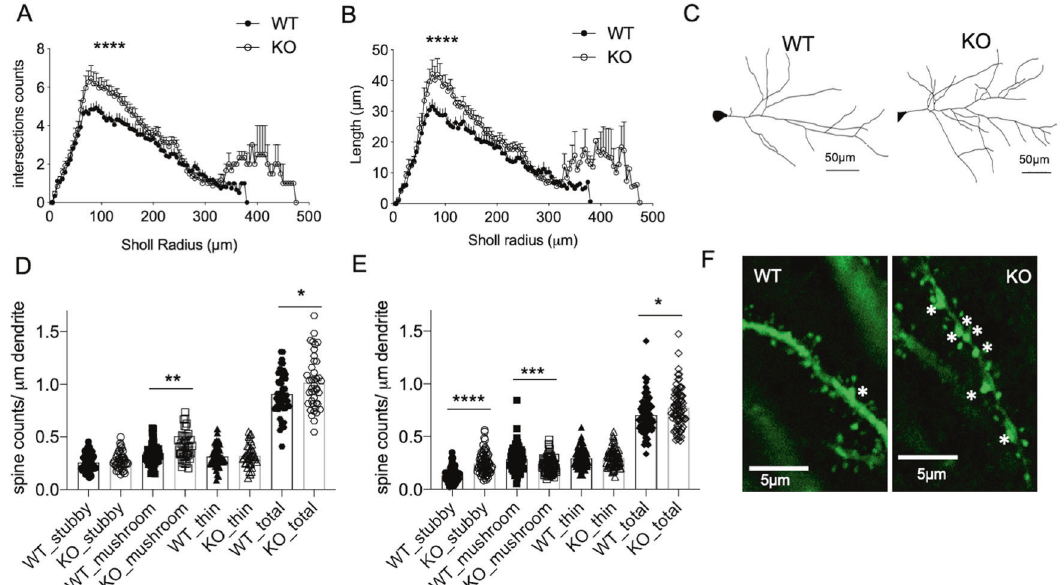
Fig. 4 Tcf4 deletion in adult excitatory neurons results in morphological alterations. A , B Sholl analysis of apical dendrite of CA1 neurons, showing number of intersection ( A ) and length ( B ) per Sholl radii 2 months post deletion. Twenty-six neurons per genotype from 3 WT and 3 KO mice. Two-way ANOVA, *** p < 0.0001, error bar represents SEM. C Representative traces of apical dendrites of CA1 neurons 2 months post deletion. D , E Spine analysis of CA1 apical dendrites at 3 weeks ( + / − SEM: 0.01 – 0.02) ( D ) and 2 months ( + / − SEM: 0.008 – 0.02) ( E ) post deletion, each dot represents counts from a dendritic segment from 3 WT, 4 KO mice for 3 weeks and 3 WT, 3 KO mice for 2 months. F Representative image showing spine in CA1 neurons 2 months post deletion, white asterisks mark stubby spines. (Student ’ s t test, **** p < 0.0001, *** p = 0.0006, ** p = 0.002, * p =